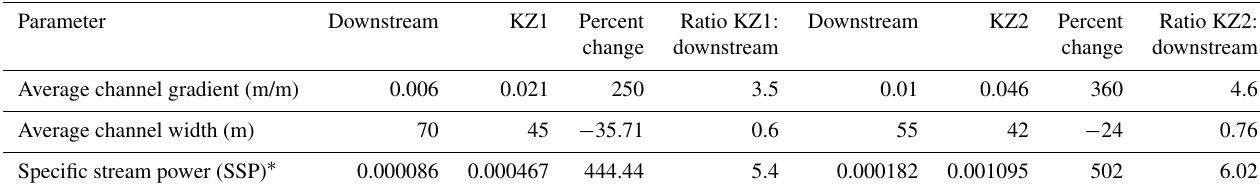
Table 1. Calculations of change in specific stream power (SSP) values across the ramp and the flat segments beneath the LH duplex. We used a uniform discharge for SSP